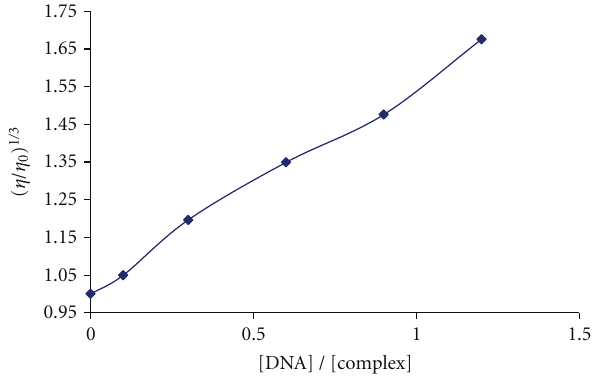
Figure 4: E ff ect of increasing amounts of complex on the viscosity of CT-DNA (5 × 10 − 5 M) in 10 mM